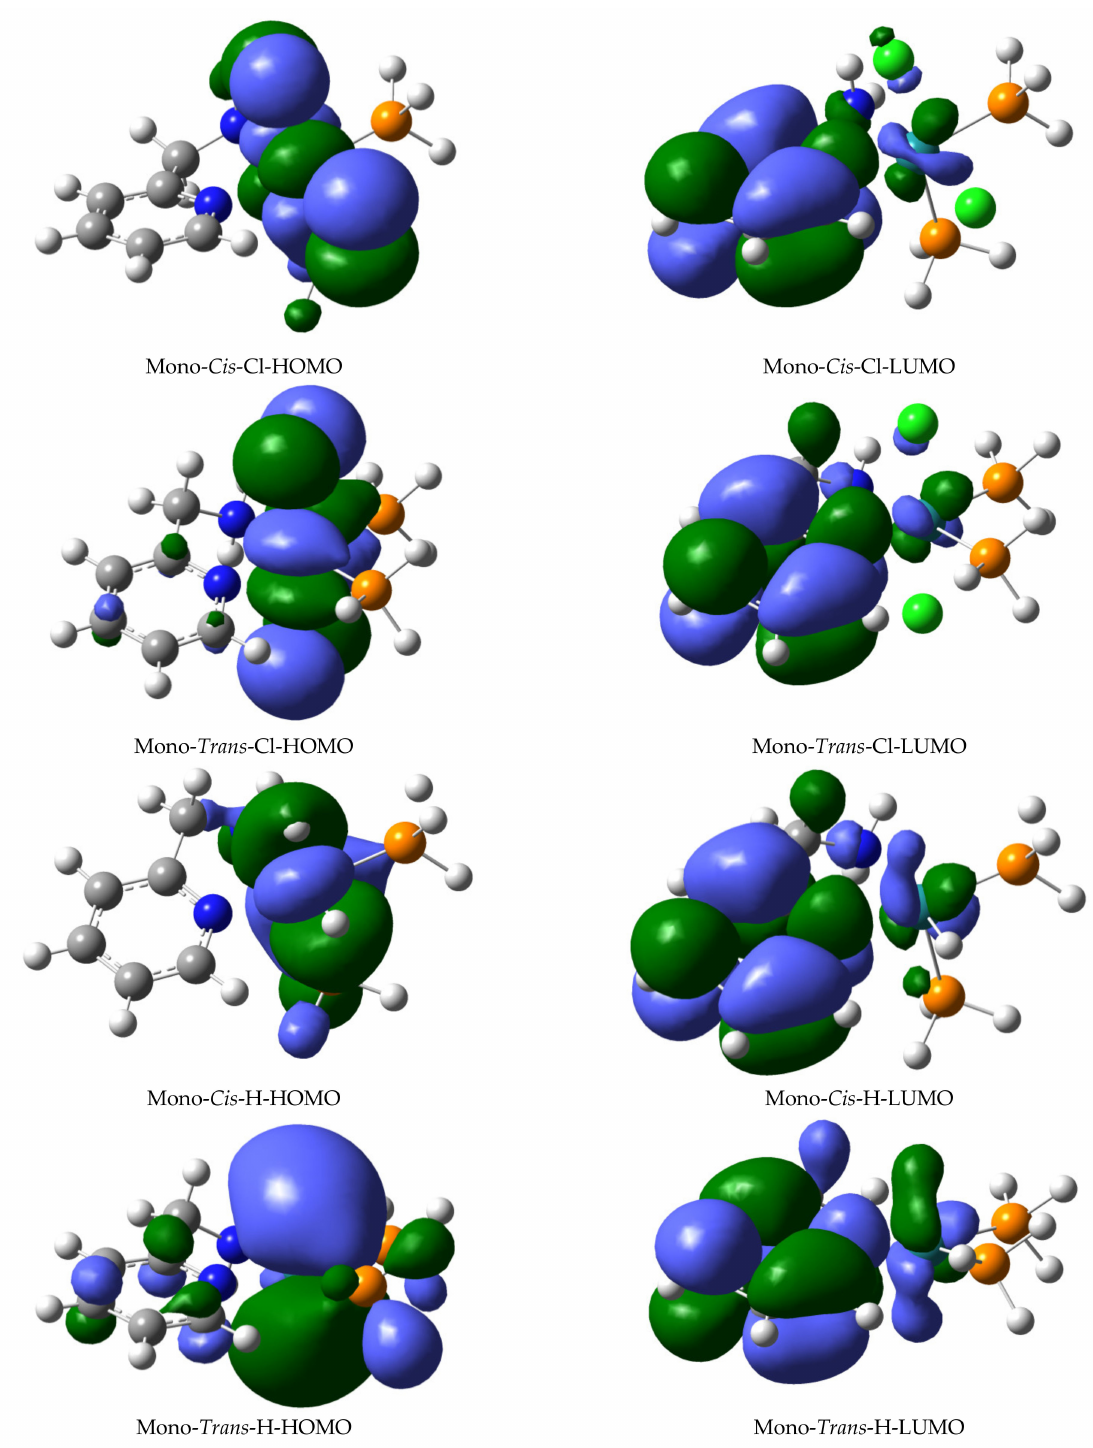
Figure 8. HOMO and LUMO molecular orbitals for the monodentate ligand Ru(II) complexes at different